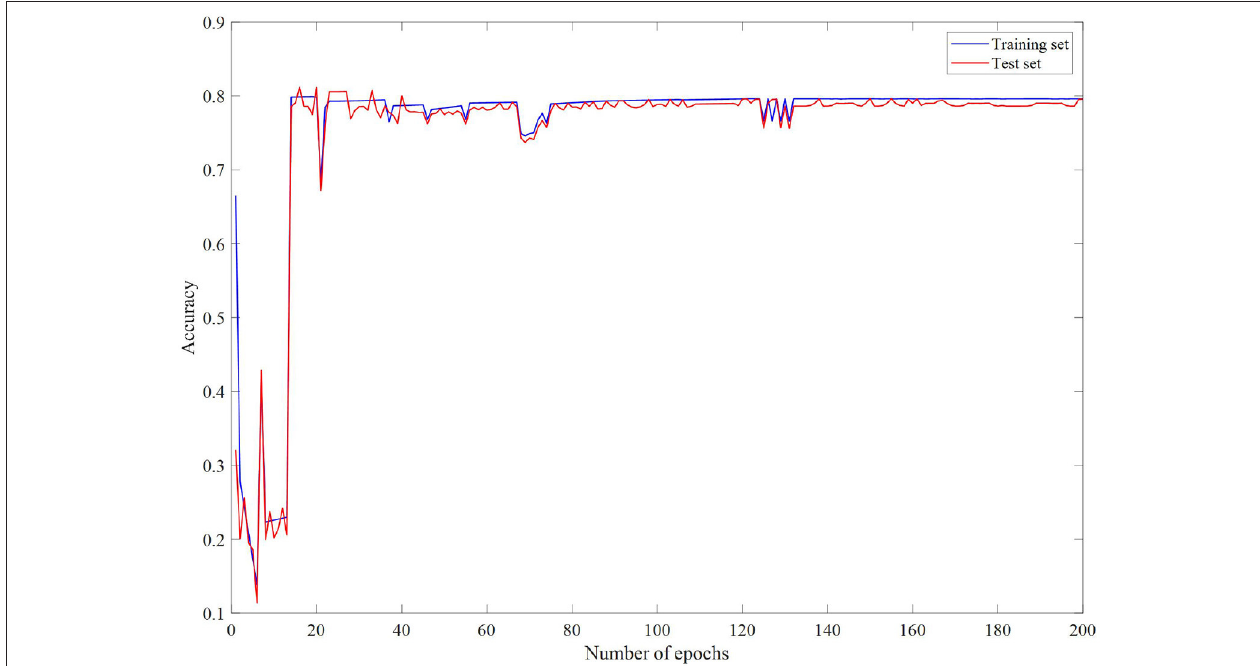
FIGURE 4 | Accuracy changes with epochs.